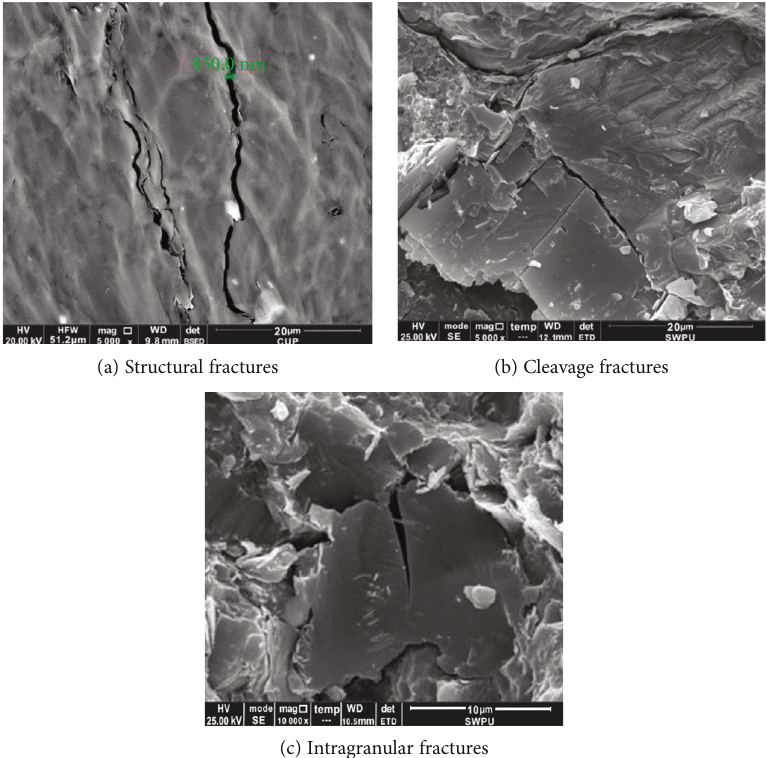
Figure 3: SEM images of natural fractures in shale [1].